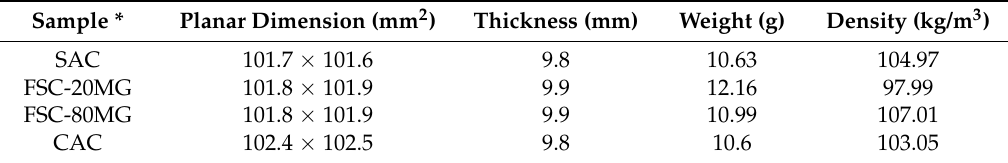
Table 5. Geometric parameters of fabricated aerogel